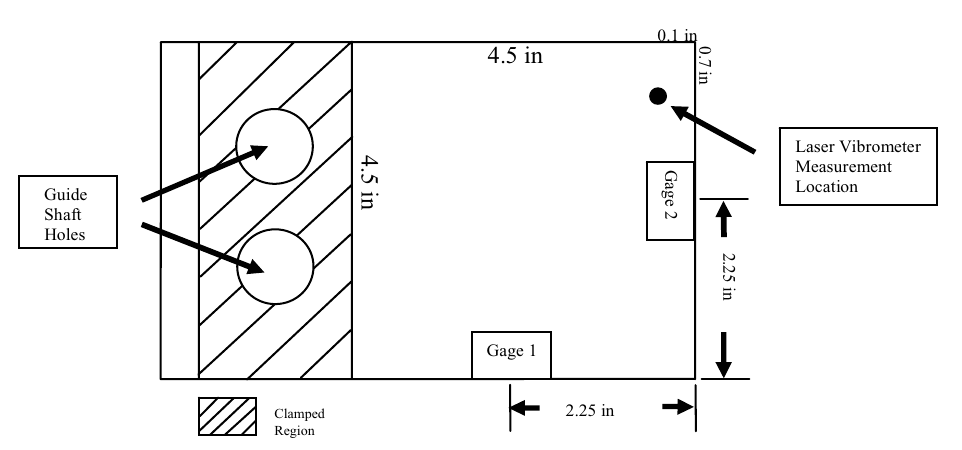
Fig. 3. Shaker table setup.